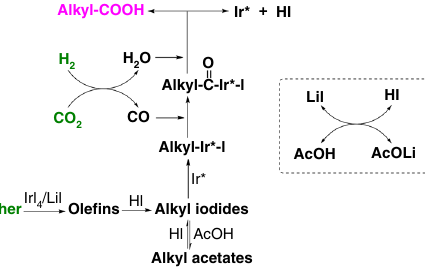
Fig. 4 The proposed reaction mechanism. Ir* represents the active center of the Ir catalyst. The ether is converted to ole fi ns, which are further transformed into alkyl iodides. The higher carboxylic acids are produced by carbonylation of alkyl iodides with CO generated in situ via